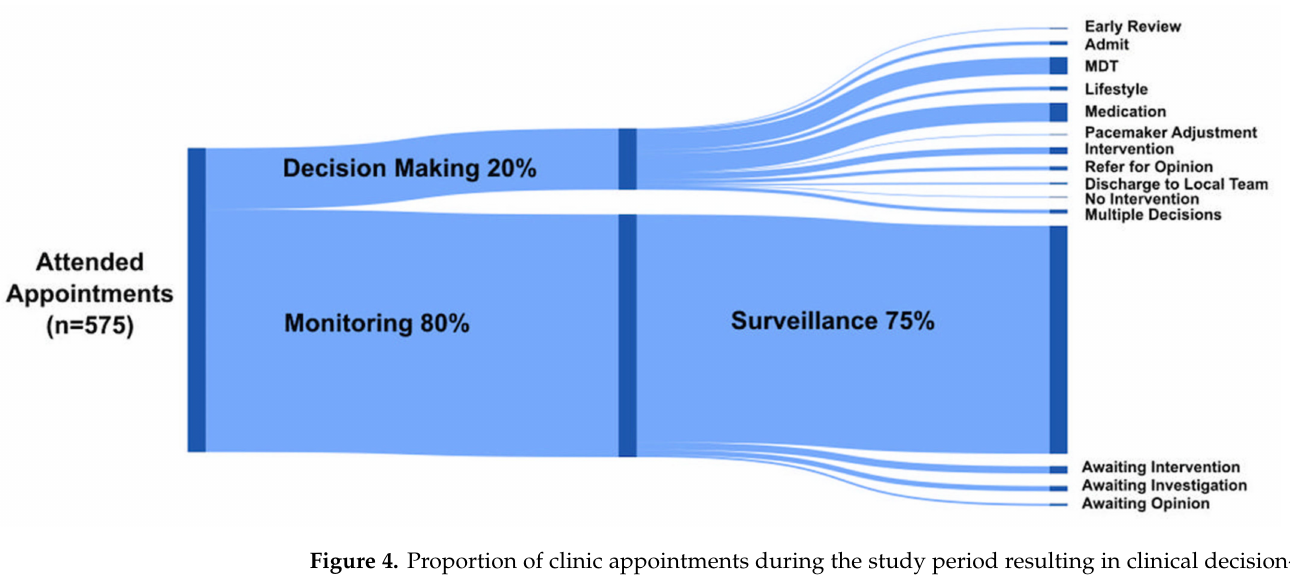
Figure 3. Frequency of nonattendance amongst the study population. DNA: Did not attend.